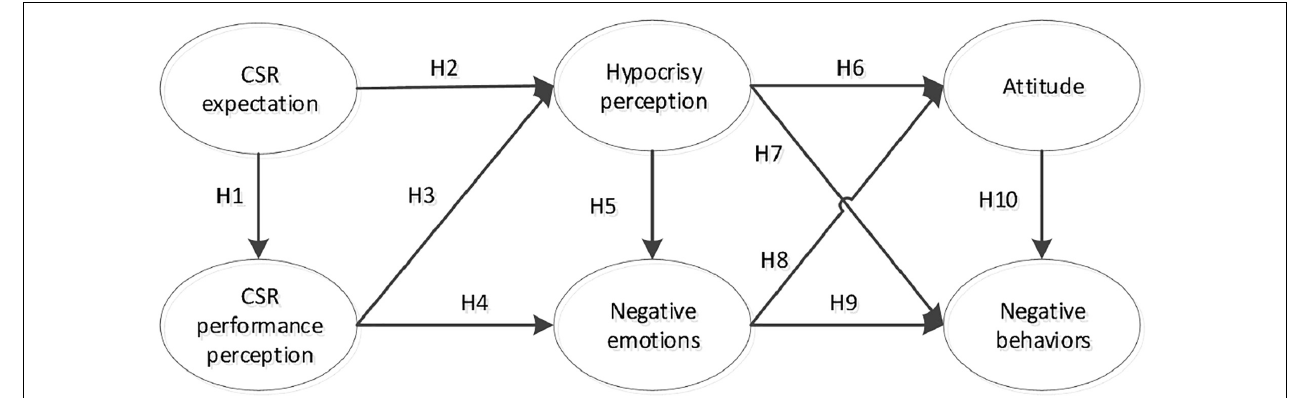
FIGURE 1 | Conceptual